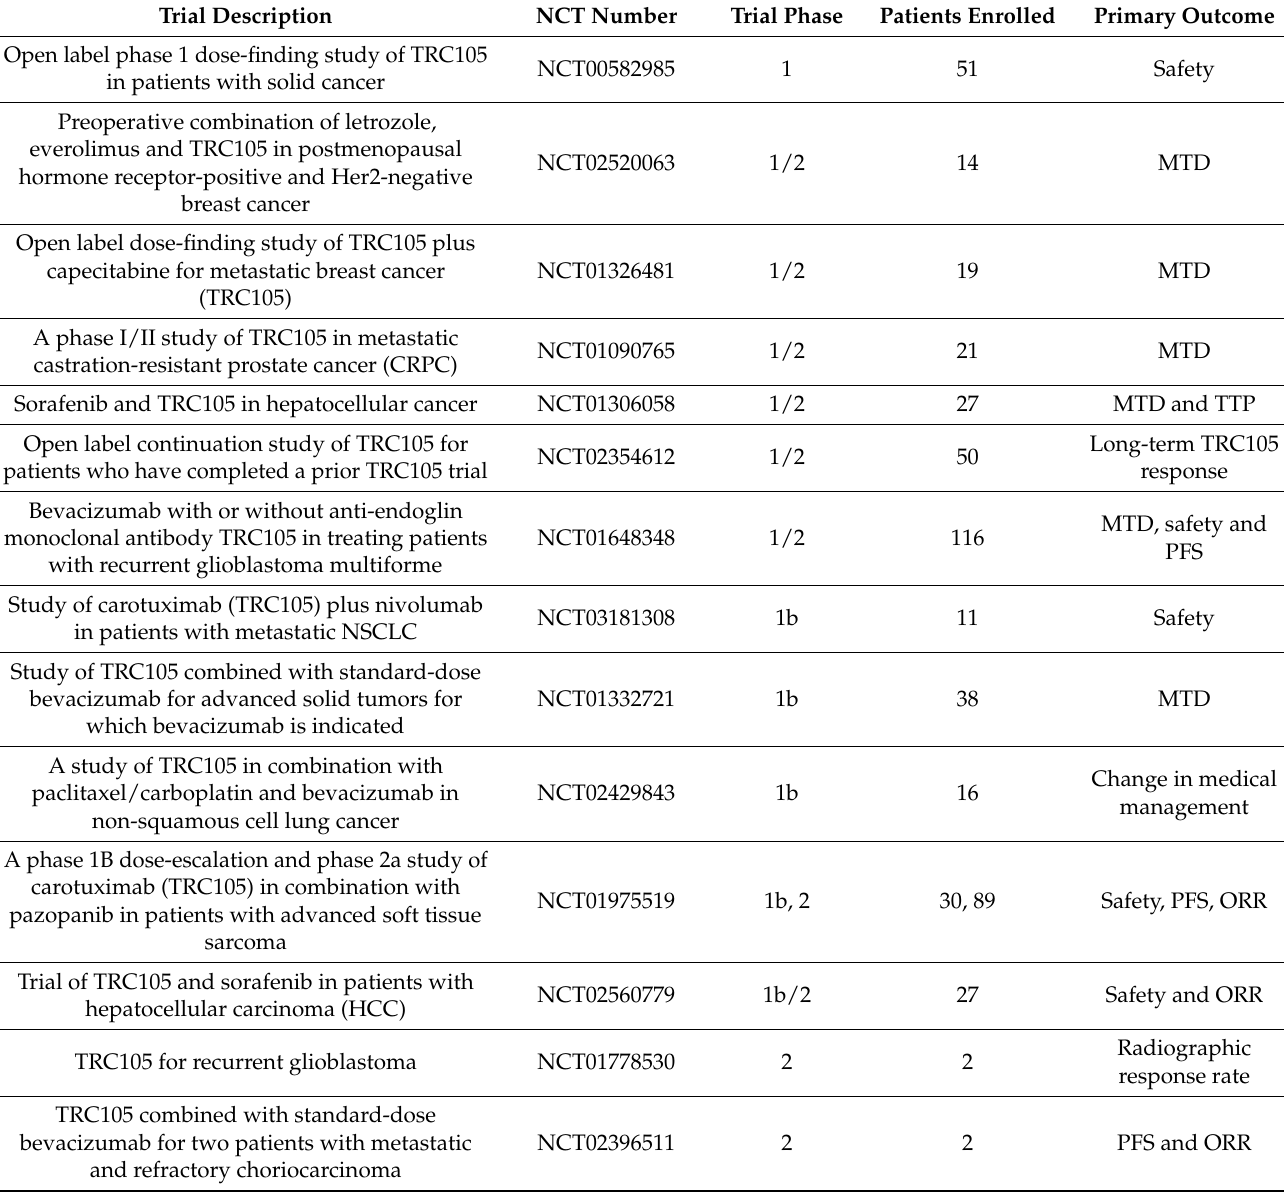
Table 1. TRC105 clinical